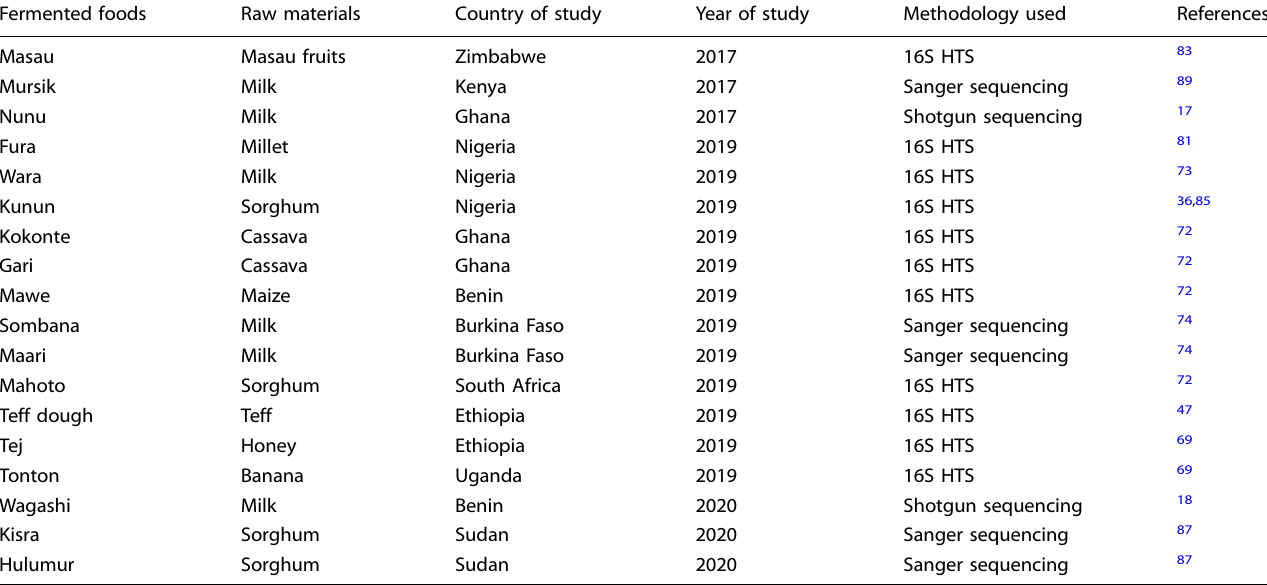
Table 2. Previous studies on the microbial analysis of predominantly consumed African fermented foods evaluated with various sequencing